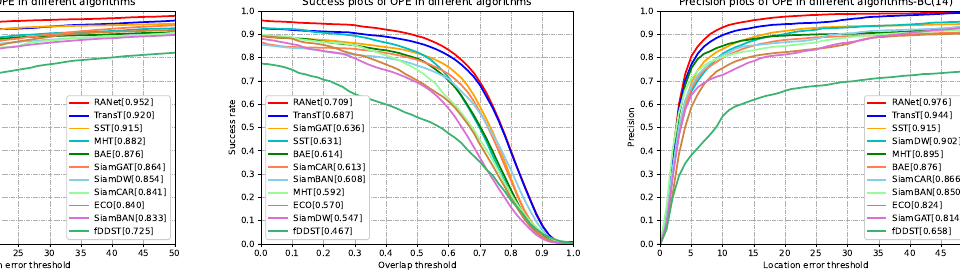
c Precision plot of background clutters